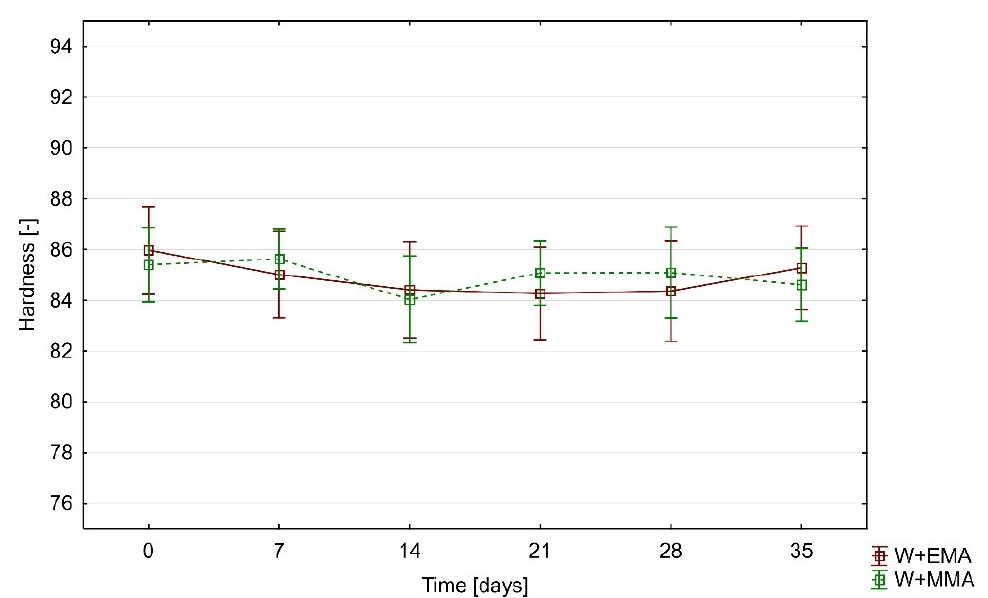
Figure 7. Change of hardness during the experiment (the Duncan’s test proved no statistically significant differences between hardness at all investigated times for both investigated samples).